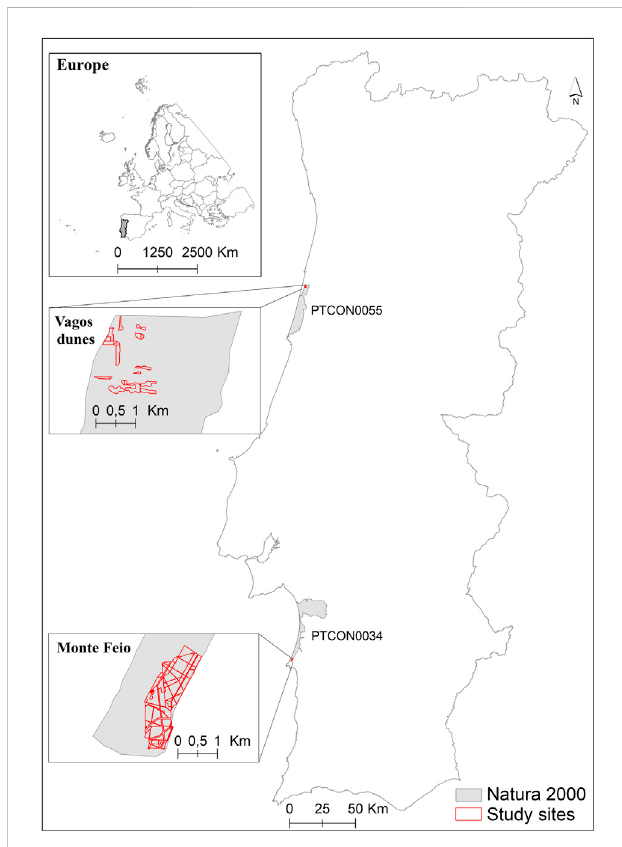
FIGURE 1 Location of the study and Natura 2000 selected sites in Portugal. Vagos dunes is a maritime pine forest ( Pinus pinaster ) managed by the public forest services, while Monte Feio is a private property where blue gum ( Eucalyptus globulus ) is planted for industrial forestry. Both areas are classi fi ed in Natura 2000 sites (PTCON0055 and PTCON0034) and are invaded by Acacia longifolia